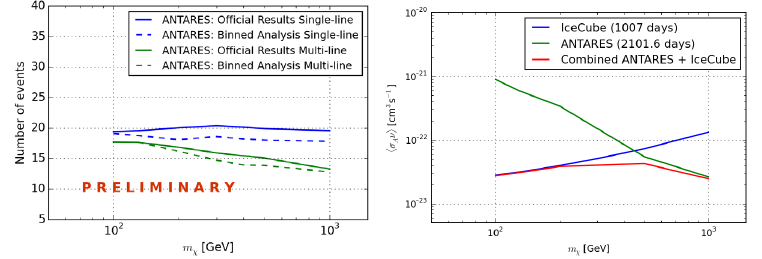
Figure 3. Left: Sensitivity to the number of events for the ANTARES sample when cross-analysed in the IceCube framework, here the W + W − channel is shown. Right: Combined sensitivities previously achieved on the thermally averaged cross section for WIMP annihilation for W + W −